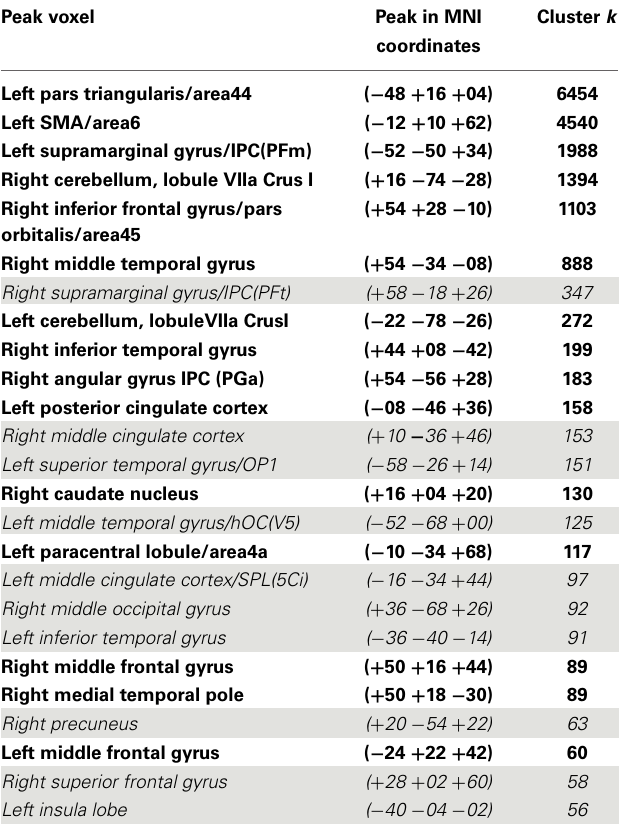
Table 1 | List of all the resting state Broca’s area network’s clusters, which possessed seeds in the left pars opercularis ( − 46 1 16 18) and the left pars triangularis ( − 53 + 20 + 15) (peak height threshold: p < 0 . 01 FDR corrected; cluster extent threshold: p < 0 . 01 FWE